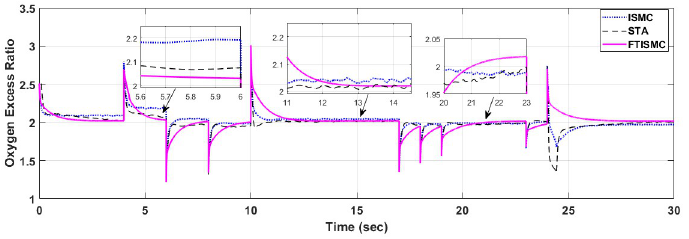
Fig 6. Comparison of OER for the three controllers.